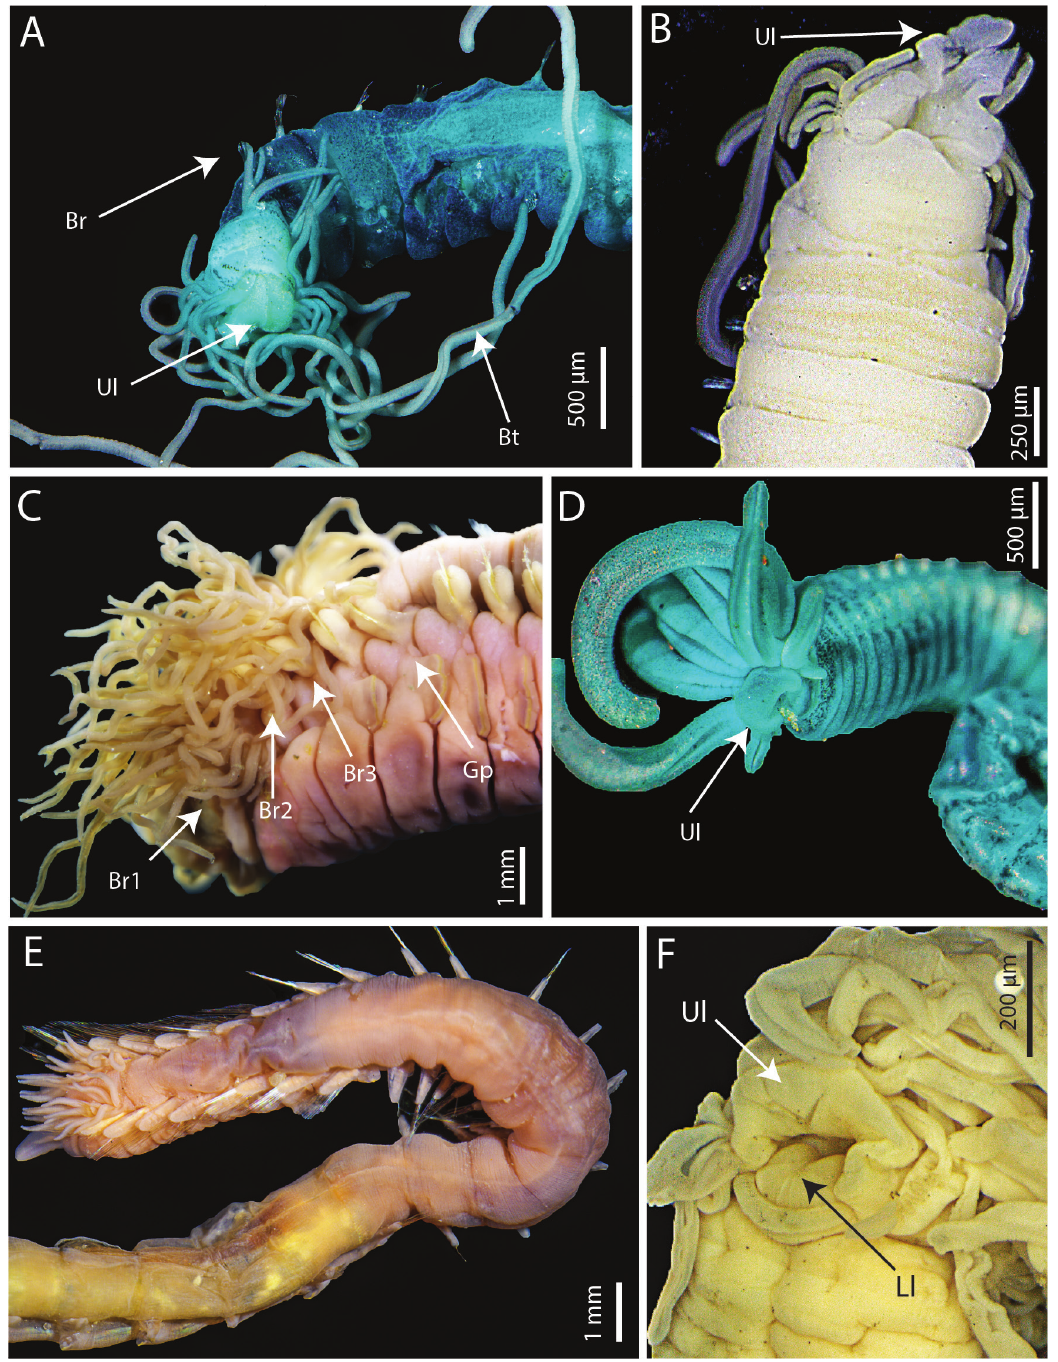
Fig. 3. Diversity of Telothelepodidae Nogueira, Fitzhugh & Hutchings, 2013 and Thelepodidae Hessle, 1917. A . Parathelepus collaris (Southern, 1914), anterior end, frontal view (AM W.53063). B . Parathelepus collaris , anterior end, ventral view (NHMUK ANEA 1983.1696). C . Thelepus japonicus Marenzeller, 1884, anterior end, lateral view (AM W.53073). D . Thelepus corsicanus Lavesque, Londoño-Mesa, Daffe & Hutchings, 2020, anterior end, frontal view (AM W.53068). E . Streblosoma cabiochi Lavesque, Londoño-Mesa, Daffe & Hutchings, 2020, anterior end, dorsal view (MNHN-IA- TYPE 2000). F . Thelepus japonicus , anterior end, ventral view (MNHN-IA-PNT 117). Abbreviations: Br = Branchiae; Bt = Buccal tentacles; Gp = genital papillae; Ll = Lower lip; Ul = Upper